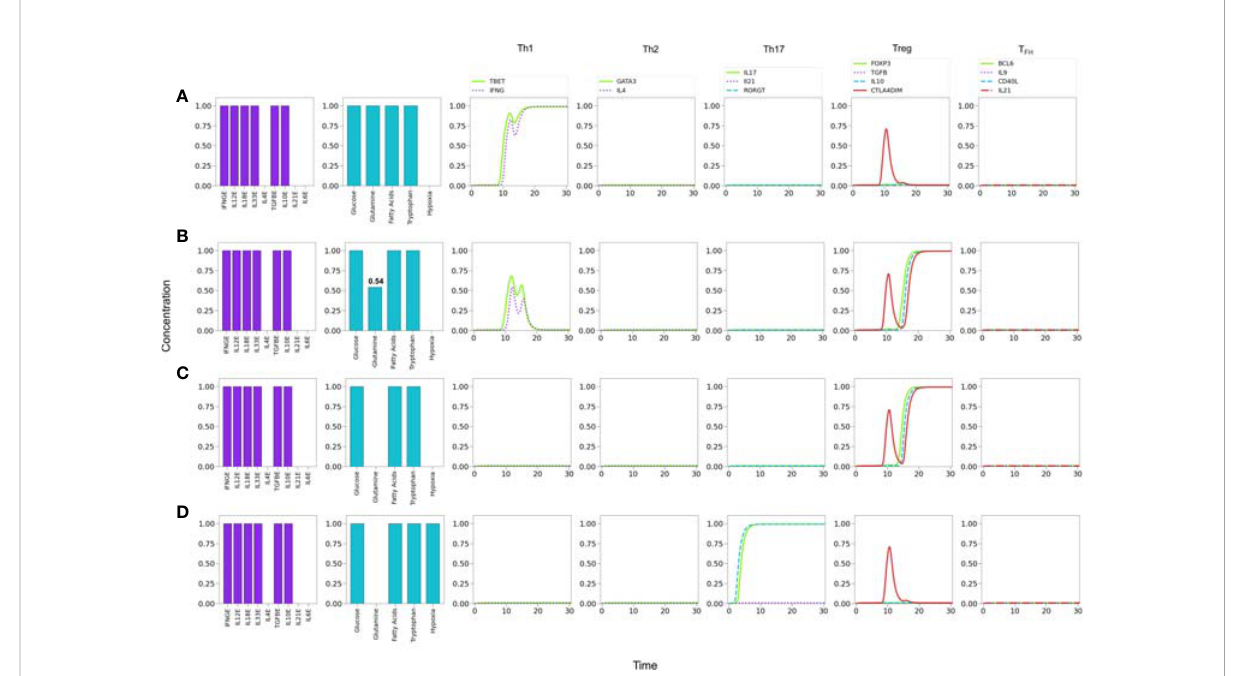
FIGURE 10 Effects of suboptimal glutamine (GLN) levels and oxygen de fi ciency in a microenvironment de fi ned by Th1 and Treg exogenous cytokines. (A) Optimal levels of GLN without hypoxia induces a Th1 phenotype. (B) GLN de fi ciency in absence of hypoxia perturbs Th1 expression; at a critical level, GLN ≤ 0.54, Th1 is inhibited allowing the expression of a Treg phenotype. (C) Total absence of GLN implies a complete inhibition of Th1 and predominance of Treg polarization. (D) Absence of GLN along with high-level hypoxia inhibits Th1 and Treg expression, promoting Th17 polarization even in absence of the pro-in fl ammatory cytokines IL-6 and